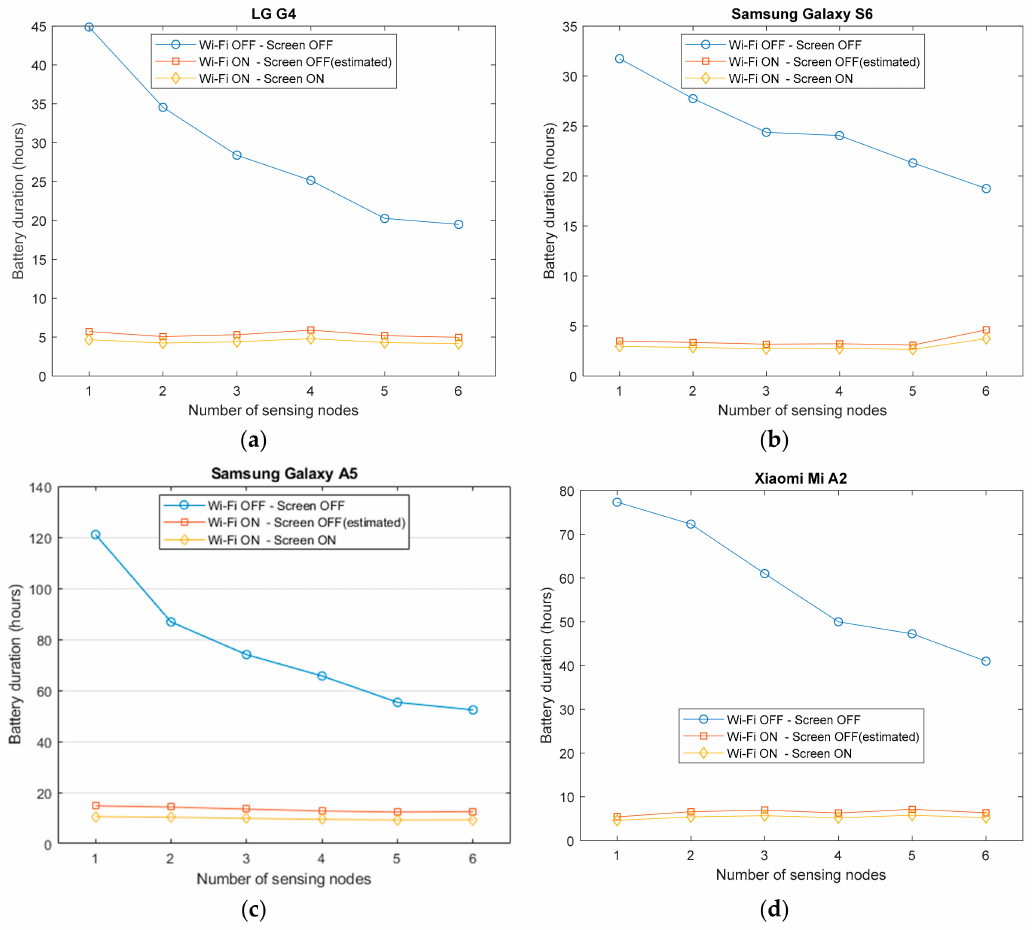
Figure 6. Impact of the use of a Wi-Fi connection to retransmit the received data to an external server. Performance metrics as a function of the number of connected sensors for a sampling rate of 50 Hz for the four considered models: ( a ) LG G4; ( b ) Samsung Galaxy S6; ( c ) Samsung Galaxy A5; ( d ) Xiaomi